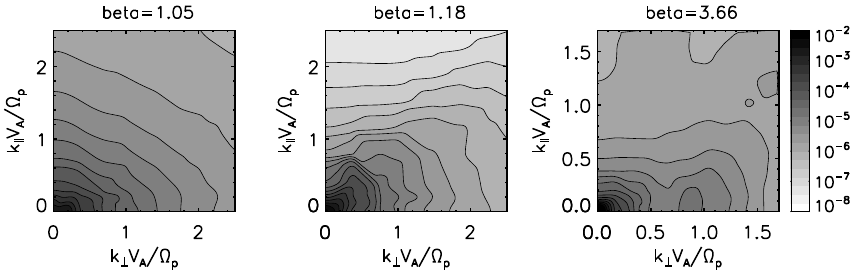
Figure 1. Magnetic energy spectra in the plane spanned by the perpendicular and parallel components of the wavevectors with respect to the large-scale magnetic field measured by Cluster spacecraft in the solar